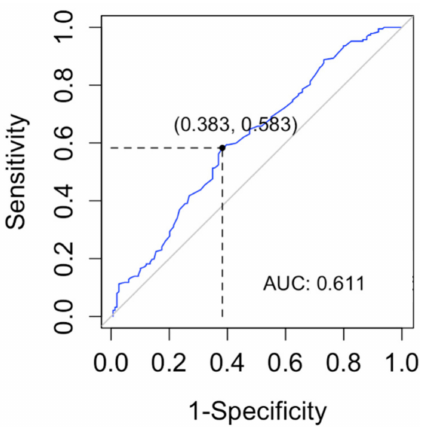
Figure 5. Receiver operating characteristic (ROC) curve was used to evaluate the lyso-Gb1 ability for classifying carrier vs. wild-type GBA1 . The area under the curve (AUC) was